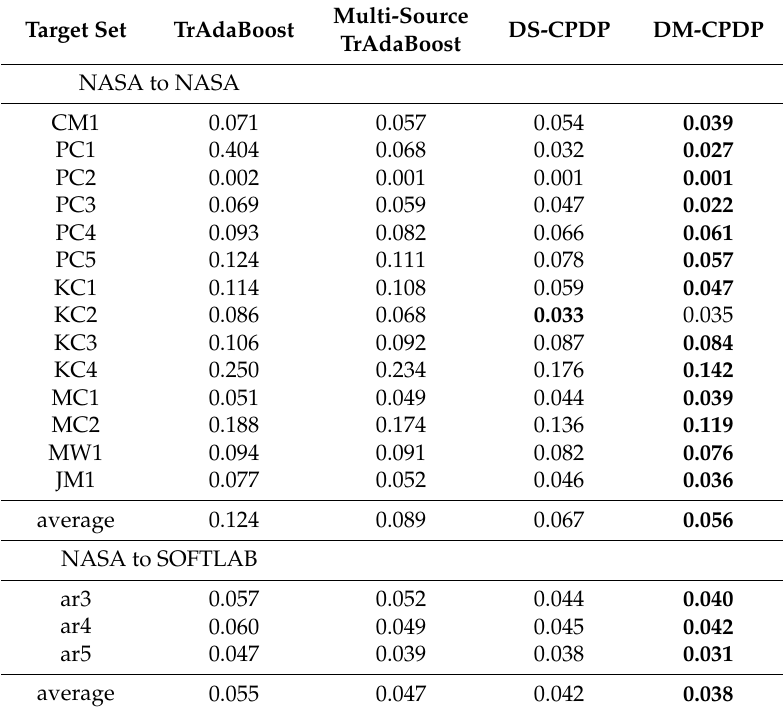
Table 9. Cost-effectiveness value of different model construction